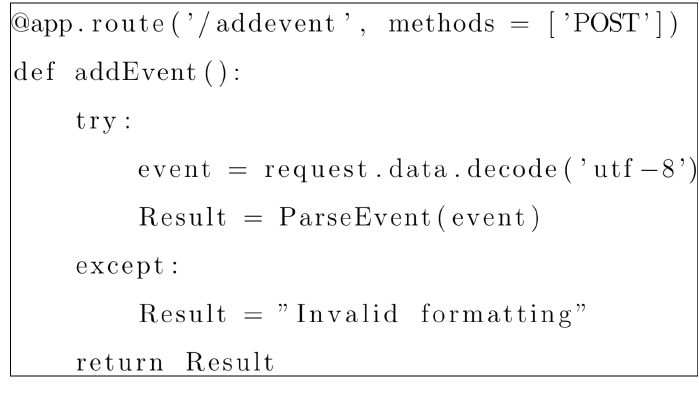
Figure 6. RESTful server—POST